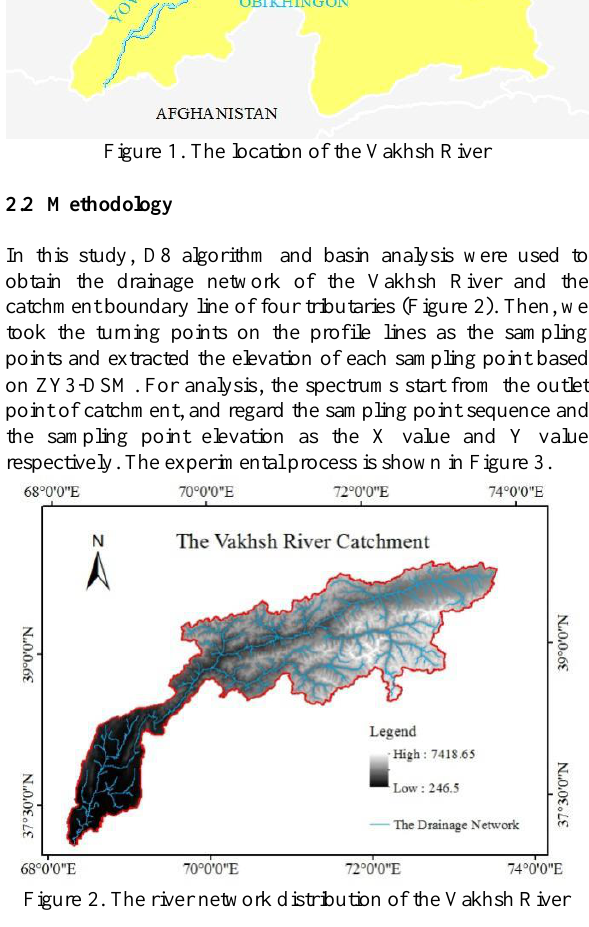
Figure 2. The river network distribution of the Vakhsh River